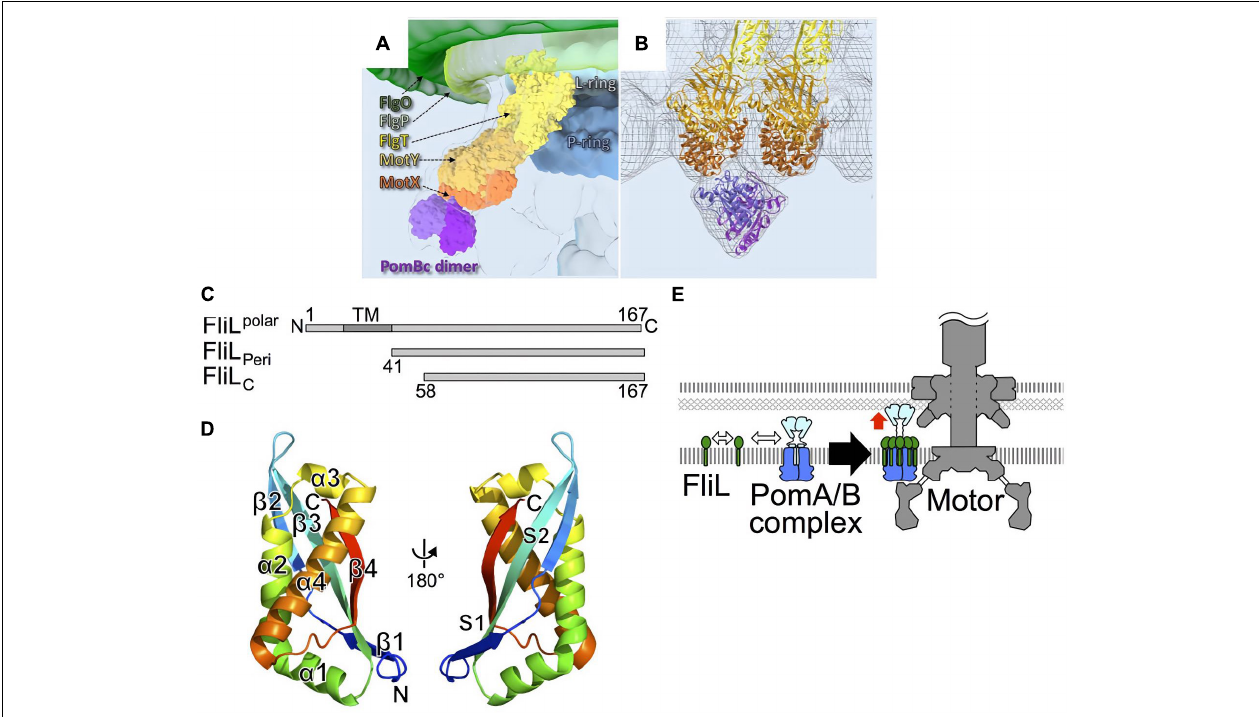
FIGURE 8 | (A) A 3D surface rendering of the part of the Vibrio flagellar basal body including the L ring and the P ring in addition to the O ring, the H ring, and the T ring. The location of the H ring is inferred based on our previous results. FlgO is labeled in deep green and located at the distal area of the H ring, and FlgP is labeled in light green and located in the middle of the H ring. FlgT might be located outside of the P/L rings and on the top of the T ring. (B) Superposition of the cryo-ET density map (mesh) and the atomic models of FlgT, MotY, MotX, and PomB, as previously shown (Zhu et al., 2020). The models are shown as ribbon diagrams and colored as in (A) . (C) Primary structure of Vibrio alginolyticus FliL and the truncations, FliL Peri , and FliL C . (D) The structure of FliL C (PDB: 6AHP) is shown as a ribbon diagram colored like a rainbow from the N-terminus (blue) to the C-terminus (red). (E) A model for the role of FliL in stator assembly. The white two-way arrows indicate the protein-protein interactions of the stator with FliL, and the red arrow indicates the activation of the stator. Figures are taken from our previous papers: Zhu et al. (2020) for (A,B) , Takekawa et al. (2019) for (C–E)